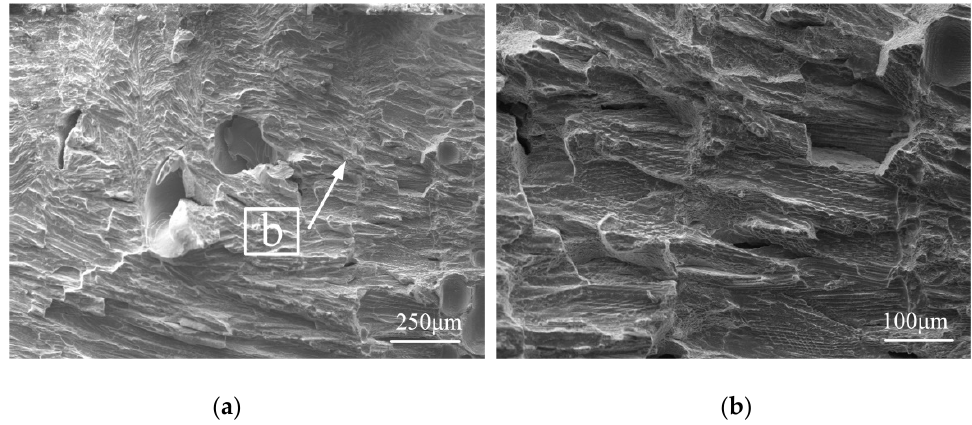
Figure 13. The fracture of the welded joint without preheating in tensile test: ( a ) The overall morphology; ( b ) the enlargement of b.